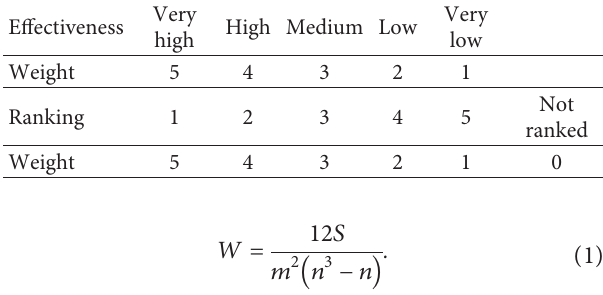
Figure 1: Flowchart showing the steps involved in the present Table 1: Weights for computing weighted mean.